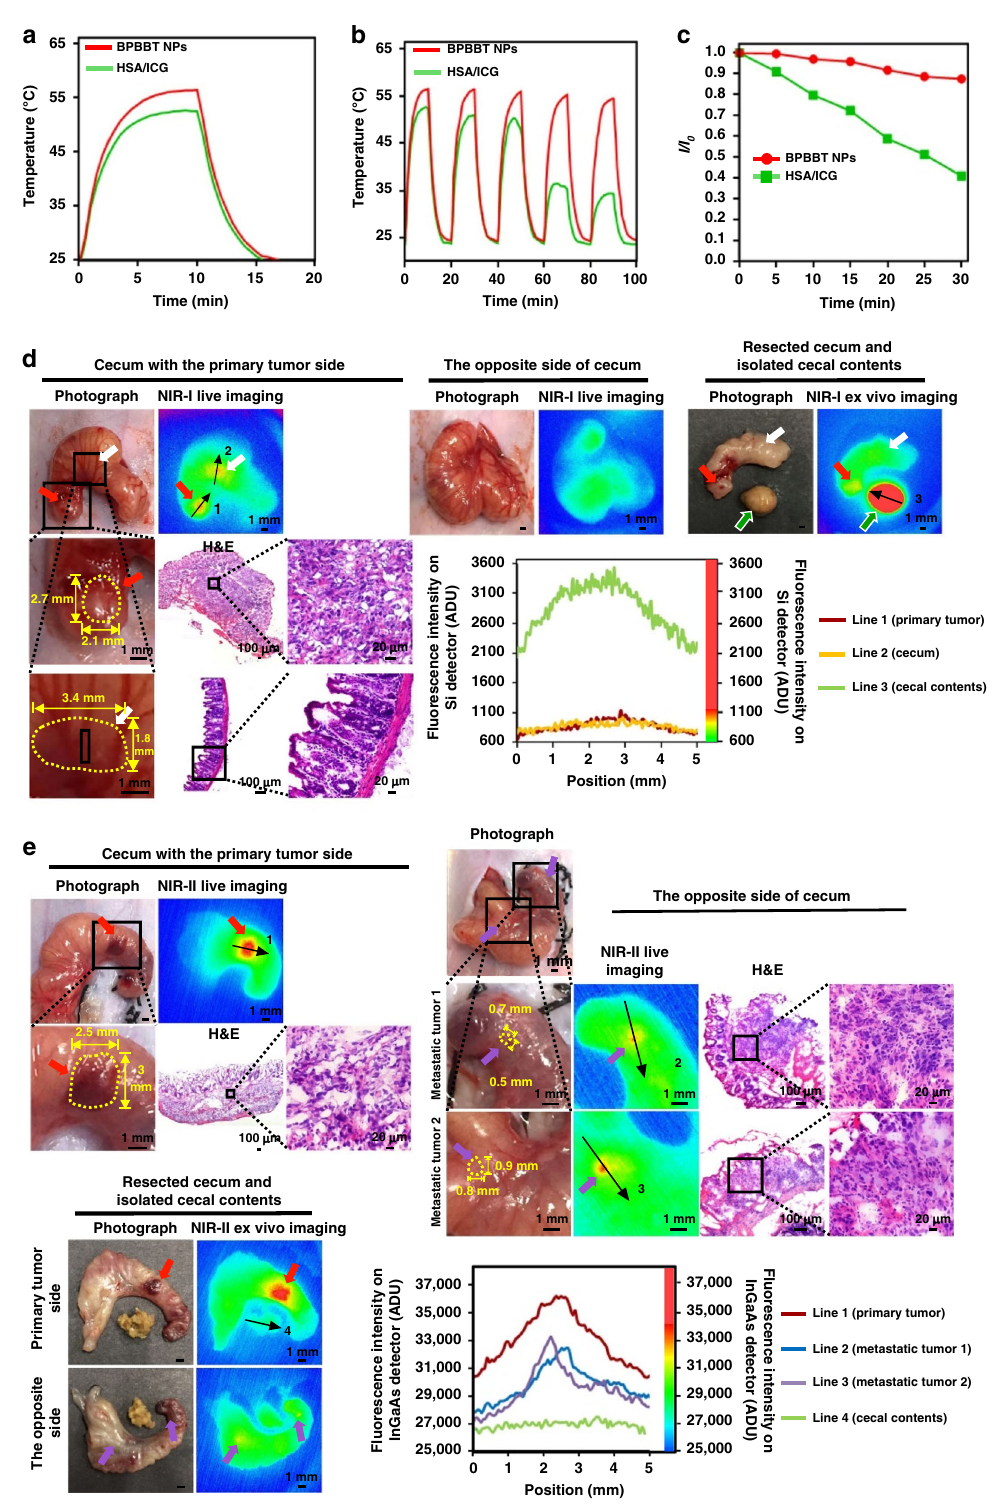
(Fig. 8a, b). The tumor-bearing mice injected with BPBBT NPs fi rstly received the intraoperative NIR-II imaging for